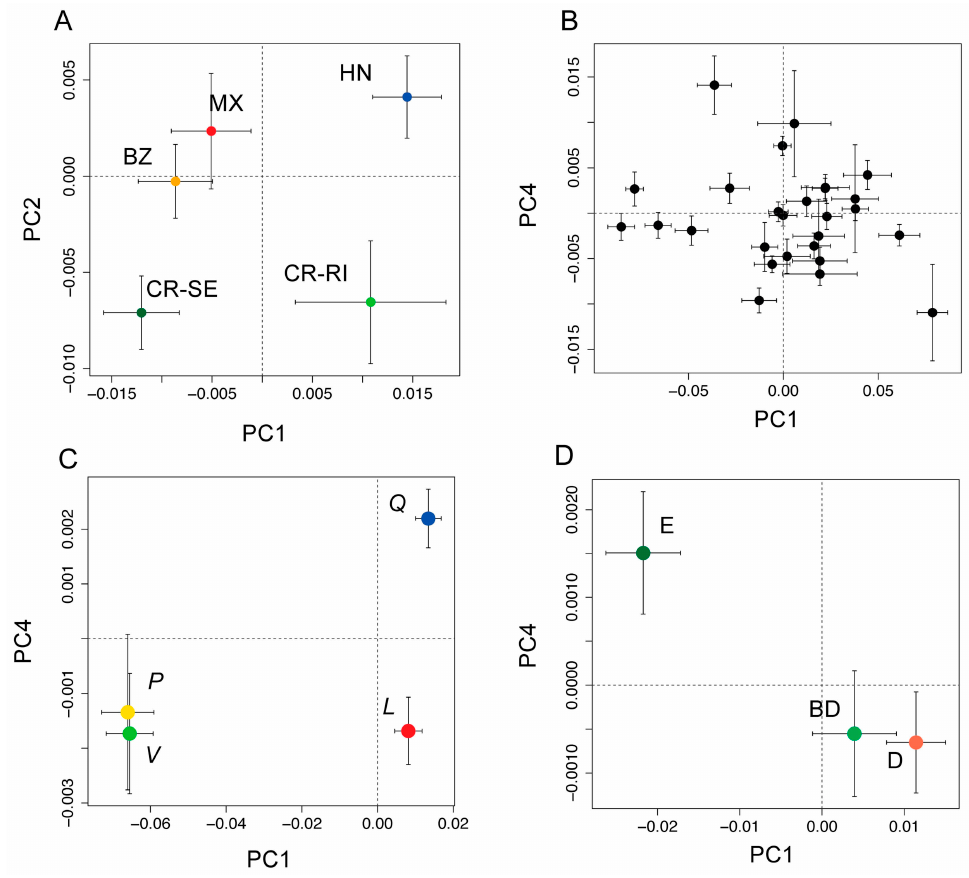
Figure 3. ( A ) Bivariate plot of population means ( ± 1 SE) from a principal coordinates (PCO) analysis PCO using leaf spectra from five populations of Quercus oleoides (BZ = Belize, MX = Mexico, HN = Honduras, CR-SE = Costa Rica, Santa Elena, and CR-RI = Costa Rica, Rincon), showing the first and second axes of variation. The first two components were significantly differentiated by population (see Table S2); ( B ) PCO scores showing population means ( ± 1 SE) for the first and fourth principal components as black circles with 95% CI. These were the first two components that had significant phylogenetic signal (see Table S2); ( C ) PCO scores for the first and fourth principal components shown for the four higher order clades (live oaks, Virentes ( V , green symbol); white oaks, section Quercus ( Q , blue symbol), red oaks, section Lobatae ( L , red symbol), and golden cup oaks, section Protobalanus ( P , gold symbol); ( D ) PCO scores for leaf type (evergreen (E), deciduous (D) or brevi-deciduous (BD)), showing the first and fourth principle components, the first two components that were significantly differentiated by leaf type (see Table S3).